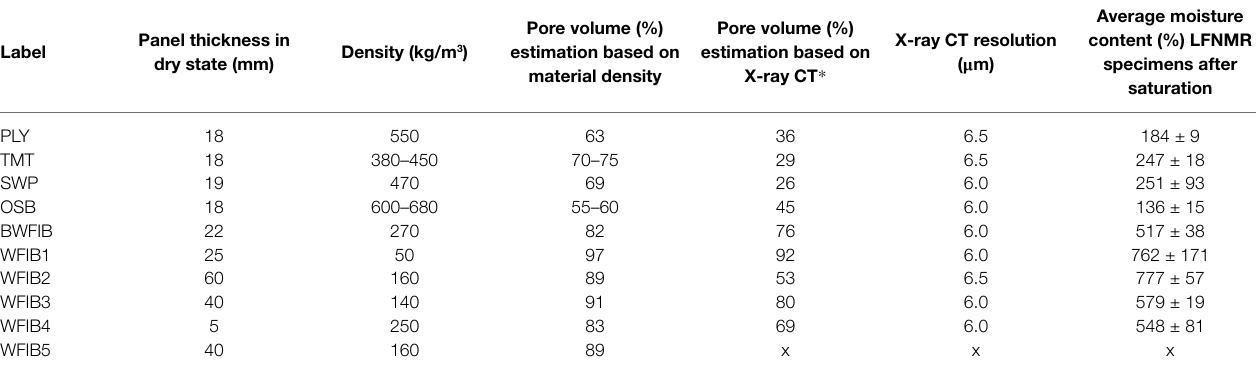
TABLE 2 | Overview of material properties: panel thickness (mm), density (kg/m 3 ), pore volume (%) estimation based on the material density relative to a solid reference density of 1,500 kg/m 3 (density of cellulose as reference value), pore volume (%) estimation of reference specimens (5 × 5 × 10 mm 3 ) assessed with X-ray micro CT and the corresponding X-ray CT resolution (µm) and average moisture content (%) of LFNMR specimens (5 × 5 × 10 mm 3 ) after water saturation under vacuum